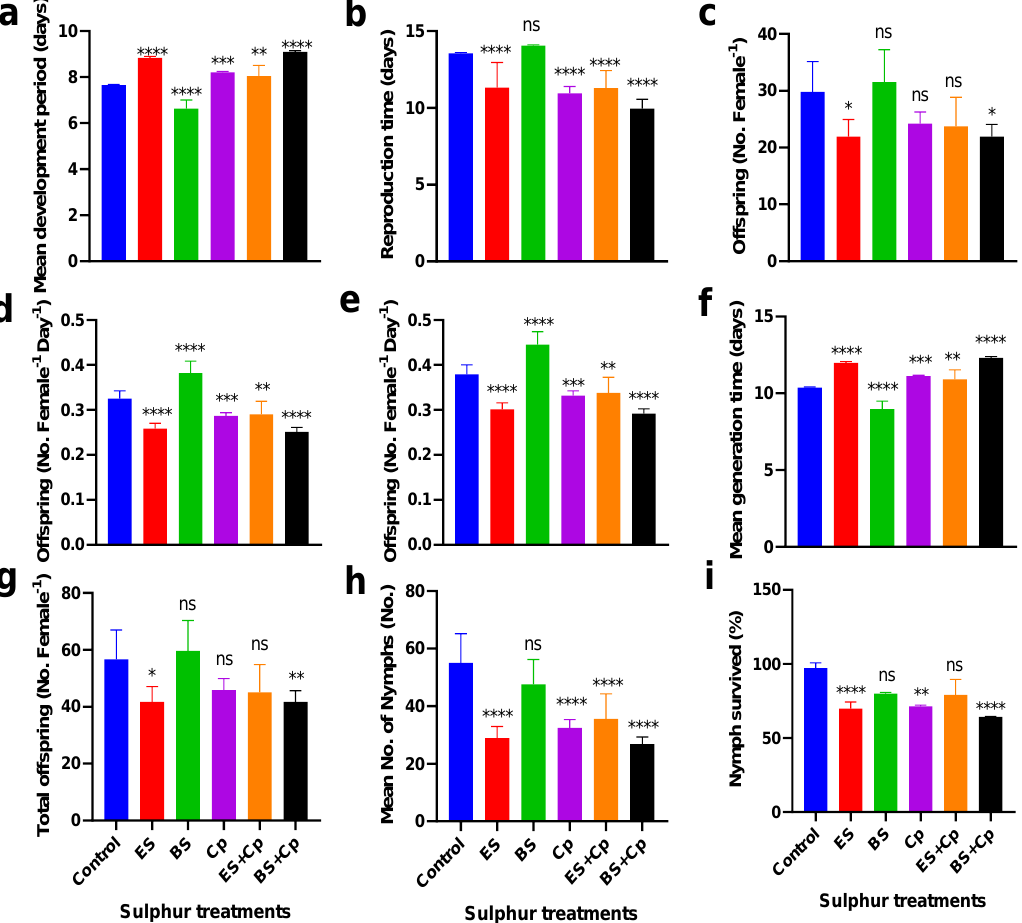
Figure 6. Effects of soil amendment treatments, ES (Elemental Sulfur), BS (Bio-Sulfur), and Cp (Compost) on different fitness attributes of Brevicoryne brassicae (Mean ± SD, n = 10). ( a ) Development period (Days). ( b ) Reproduction time (Days). ( c ) Effective fecundity (No. Female − 1 ). ( d ) Intrinsic rate of natural increase (No. Female − 1 Day − 1 ). ( e ) Relative growth rate (No. Female − 1 Day − 1 ). ( f ) Generation time (Days). ( g ) Total progeny production (No. Female − 1 ). ( h ) Progeny nymphs reaching adulthood (No. Female). ( i ) Progeny nymph survival (%). Statistical significance of p in post hoc tests: ns ≥ 0.05, * <0.05, ** <0.01, *** <0.001, **** <0.0001.